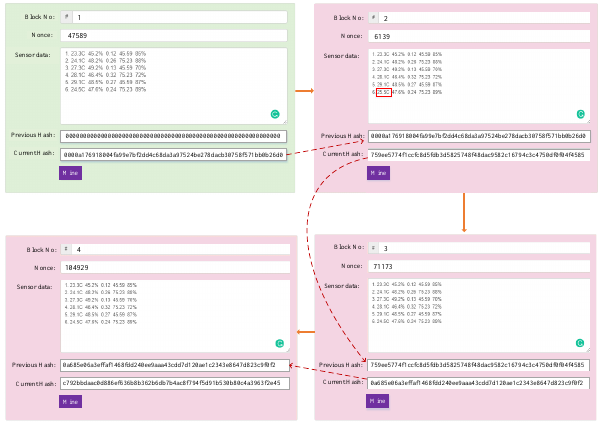
Figure 12. Result when have change data